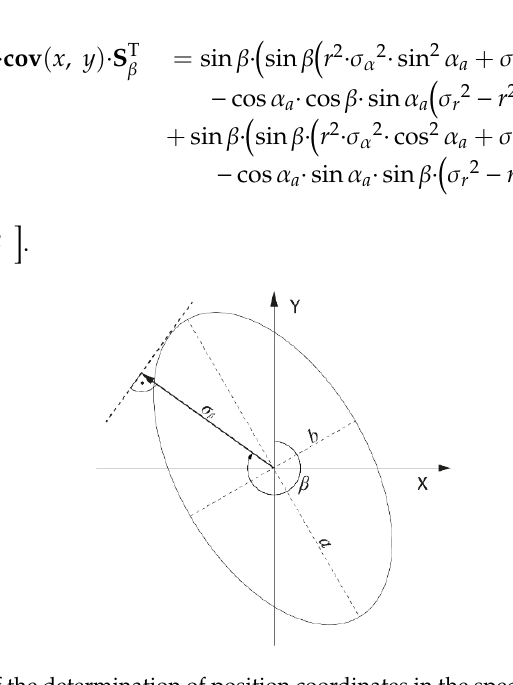
Figure 2. Mean error of the determination of position coordinates in the specified direction. (calculated using the covariance matrix).